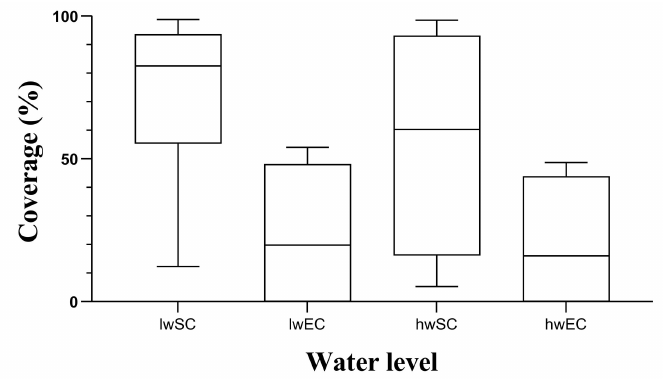
Figure 5. The influence of water level on the succession of submerged and emergent macrophytes. lwSC stands for low water level submerged macrophyte coverage; lwEC stands for low water level emergent plant coverage; hwSC stands for high water level submerged macrophyte coverage; hwEC stands for high water level emergent plant coverage.